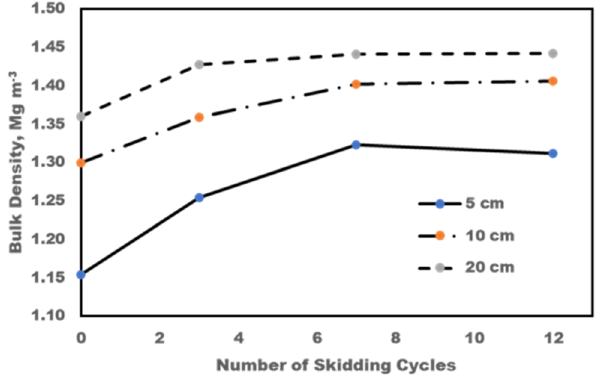
Figure 4. Bulk density measured immediately after harvesting and skidding (year 0) as a function of the number of skidding cycles.